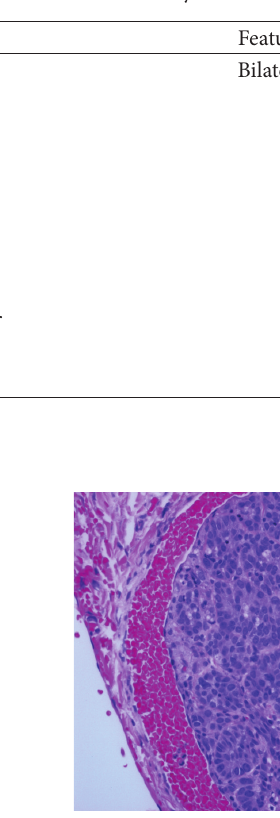
Table 2: Features favoring diagnosis of MDNC of larynx.